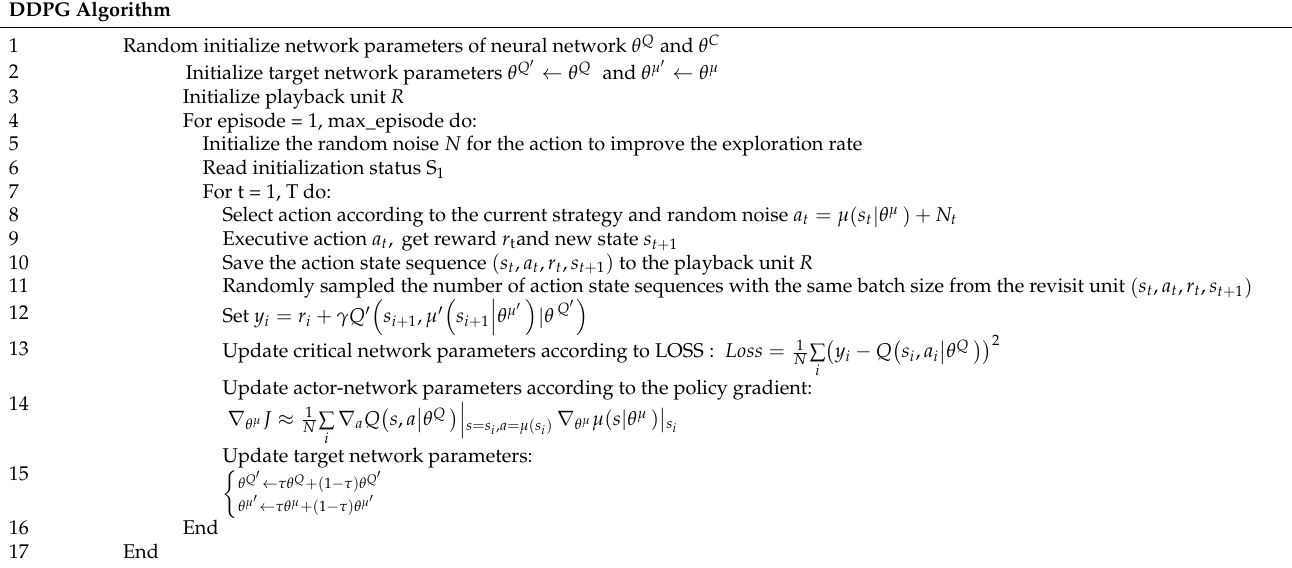
Table 2. The DDPG